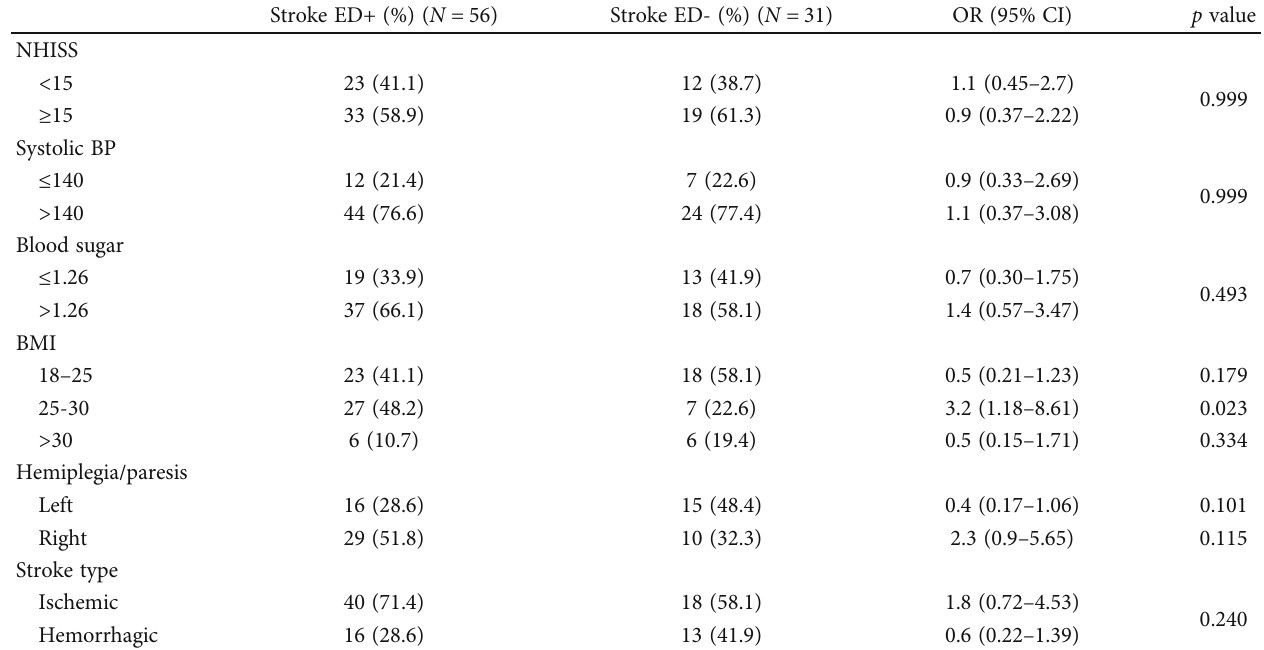
Table 3: Clinical and paraclinical characteristics of stroke patients.